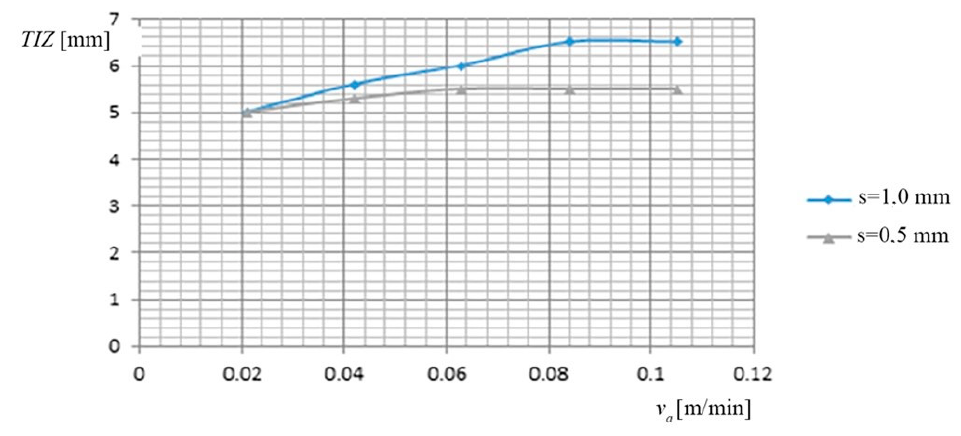
Figure 5. Dependence Thermal Influenced Zone ( TIZ ) on PO and thickness ( s ). Table 6. Dependence of the thermal influenced area on the working current, on the feed rate of PO, and by the thickness of the metal band.